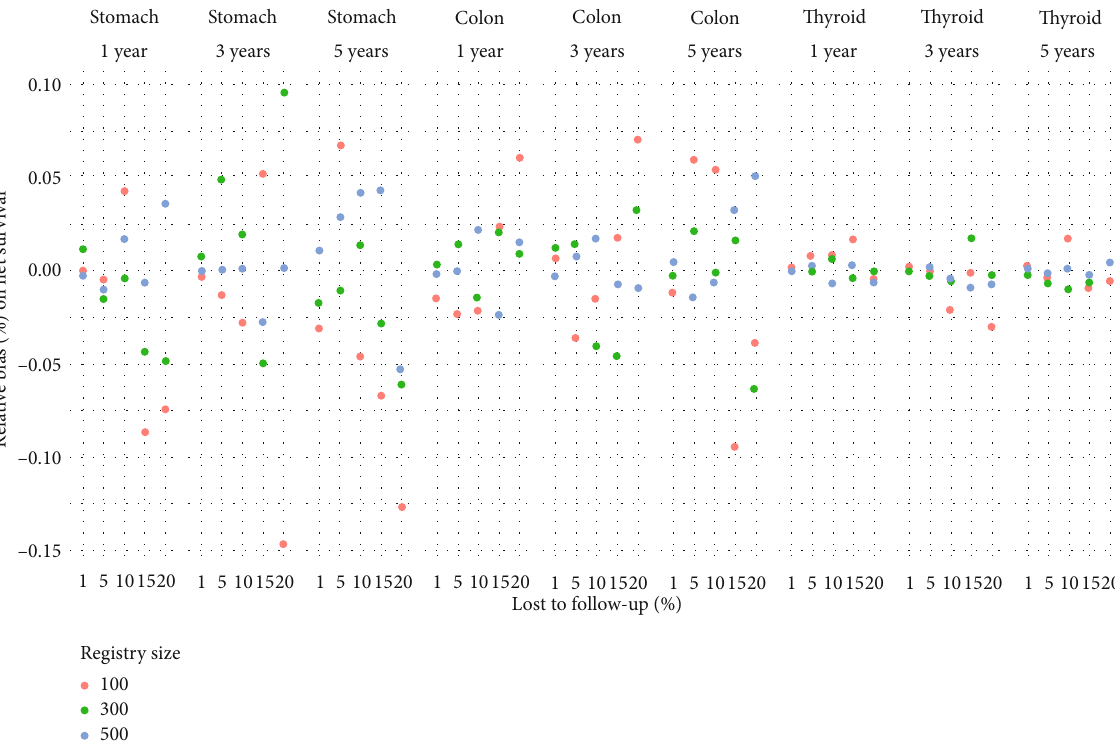
Figure 4: Relative bias (%) on overall survival due to excluding lost to follow-up cases by cancer localization, follow-up time, percentage lost to follow-up, and registry